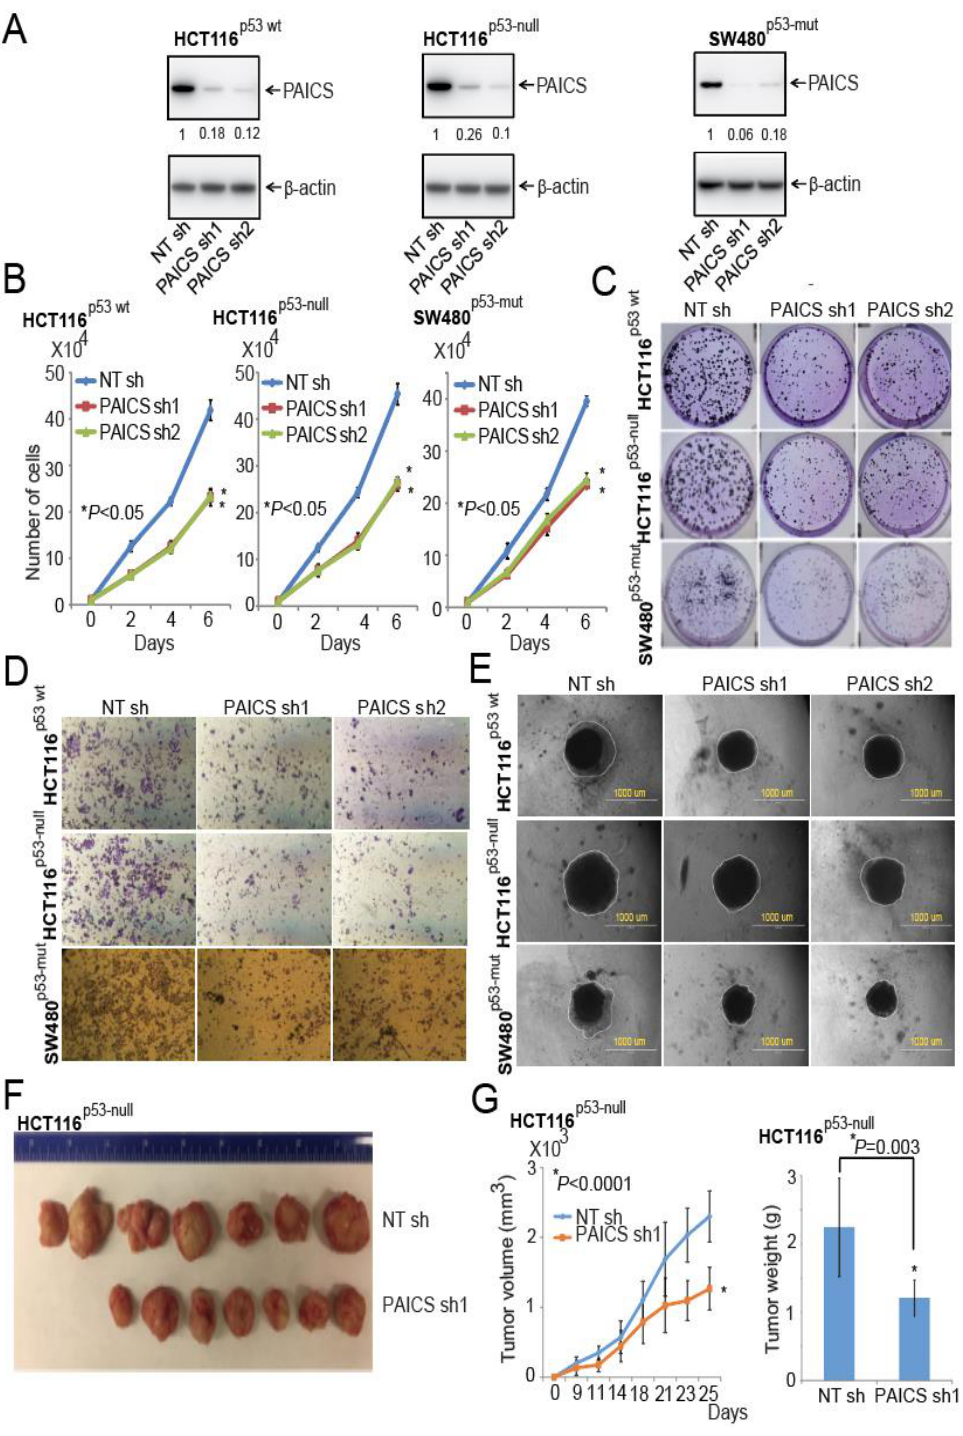
Figure 3. PAICS silencing retards CRC cell and tumor growth. ( A ) Immunoblot analysis using protein lysates from CRC cells, HCT116 p53-wt , HCT116 p53-null , and SW480 p53-mut , which were stably transfected with PAICS shRNAs, showed PAICS protein reduction as compared to cells transfected with NT shRNA. β -Actin was used as a loading control. Densitometric readings for Western Blots were calculated, and values were normalized relative to β -actin. These values are provided below the blots of the PAICS expression. The stable knockdown of PAICS in CRC cells reduced cell proliferation ( B ) and colony formation ( C ). ( D ) Representative images showing less invasion of PAICS-knockdown CRC